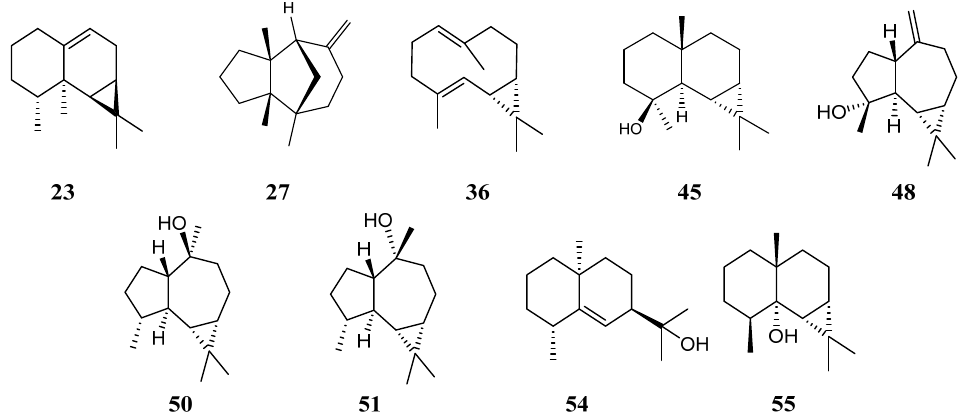
Figure 1. Structures of P. porelloides essential oil components identified by GC-MS and ensured by